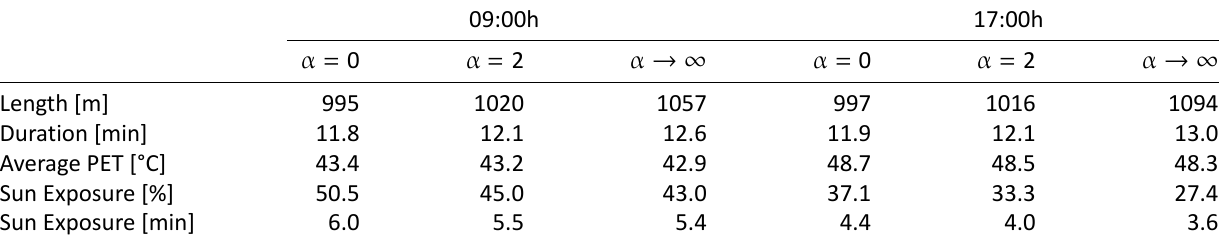
Figure 7. Thermal comfort map (Physiologically Equivalent Temperature, PET, in °C) for Arizona State University’s Tempe campus for August 7, 2016, 09:00h (a) and 17:00h (b); Shortest path (dotted line) from the Ira A. Fulton Schools of Engineer- ing (Brickyard) to the Memorial Union, slightly longer, but more comfortable route (dashed line), and most comfortable path (solid